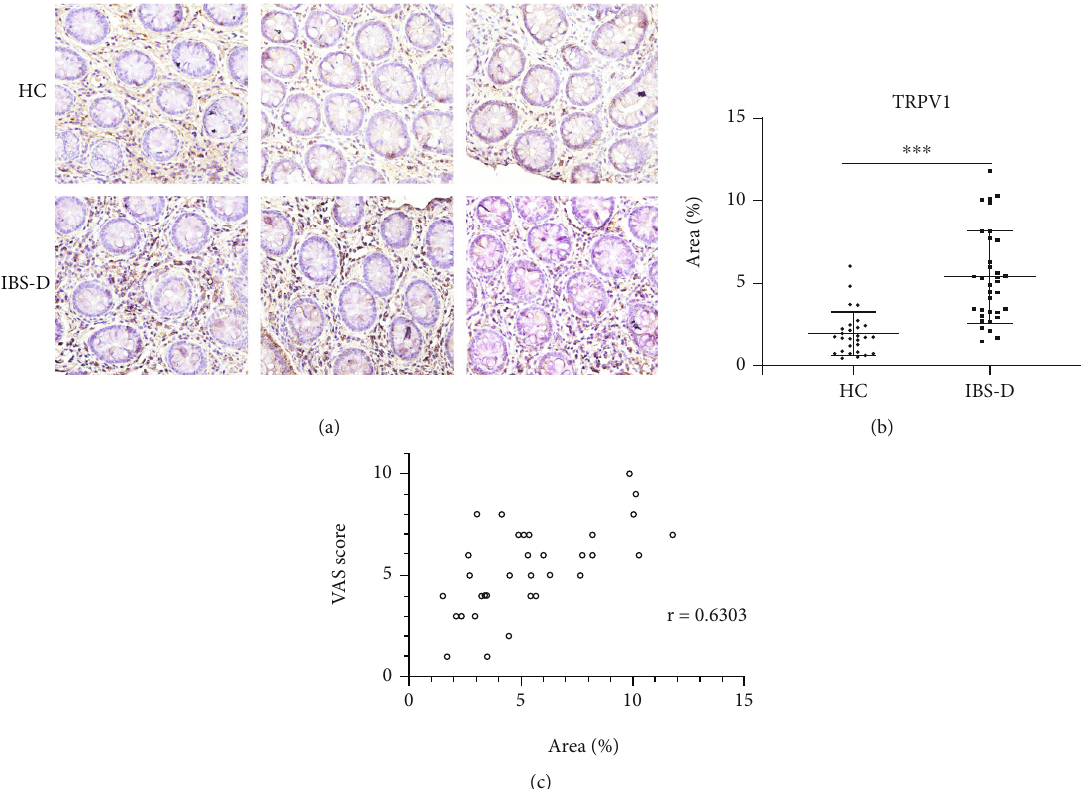
Figure 2: Expression of TRPV1 was increased in the colonic mucosa of IBS-D patients and correlated with the severity of the disease. (a, b) Expression of TRPV1 in the colonic mucosa of IBS-D patients was higher than that of HCs. (c) Expression of TRPV1 in the colonic mucosa correlated with the severity of IBS-D. Scale bar, 50 μ M. ∗∗∗ p < 0 : 001 ( p = 0 : 0075 , r = 0 : 4506 , Figure 3(c)). TRPV4 was another TRP channel with enhanced expression in the colonic mucosa of IBS-D patients (Figures 3(d) and 3(e)). However,